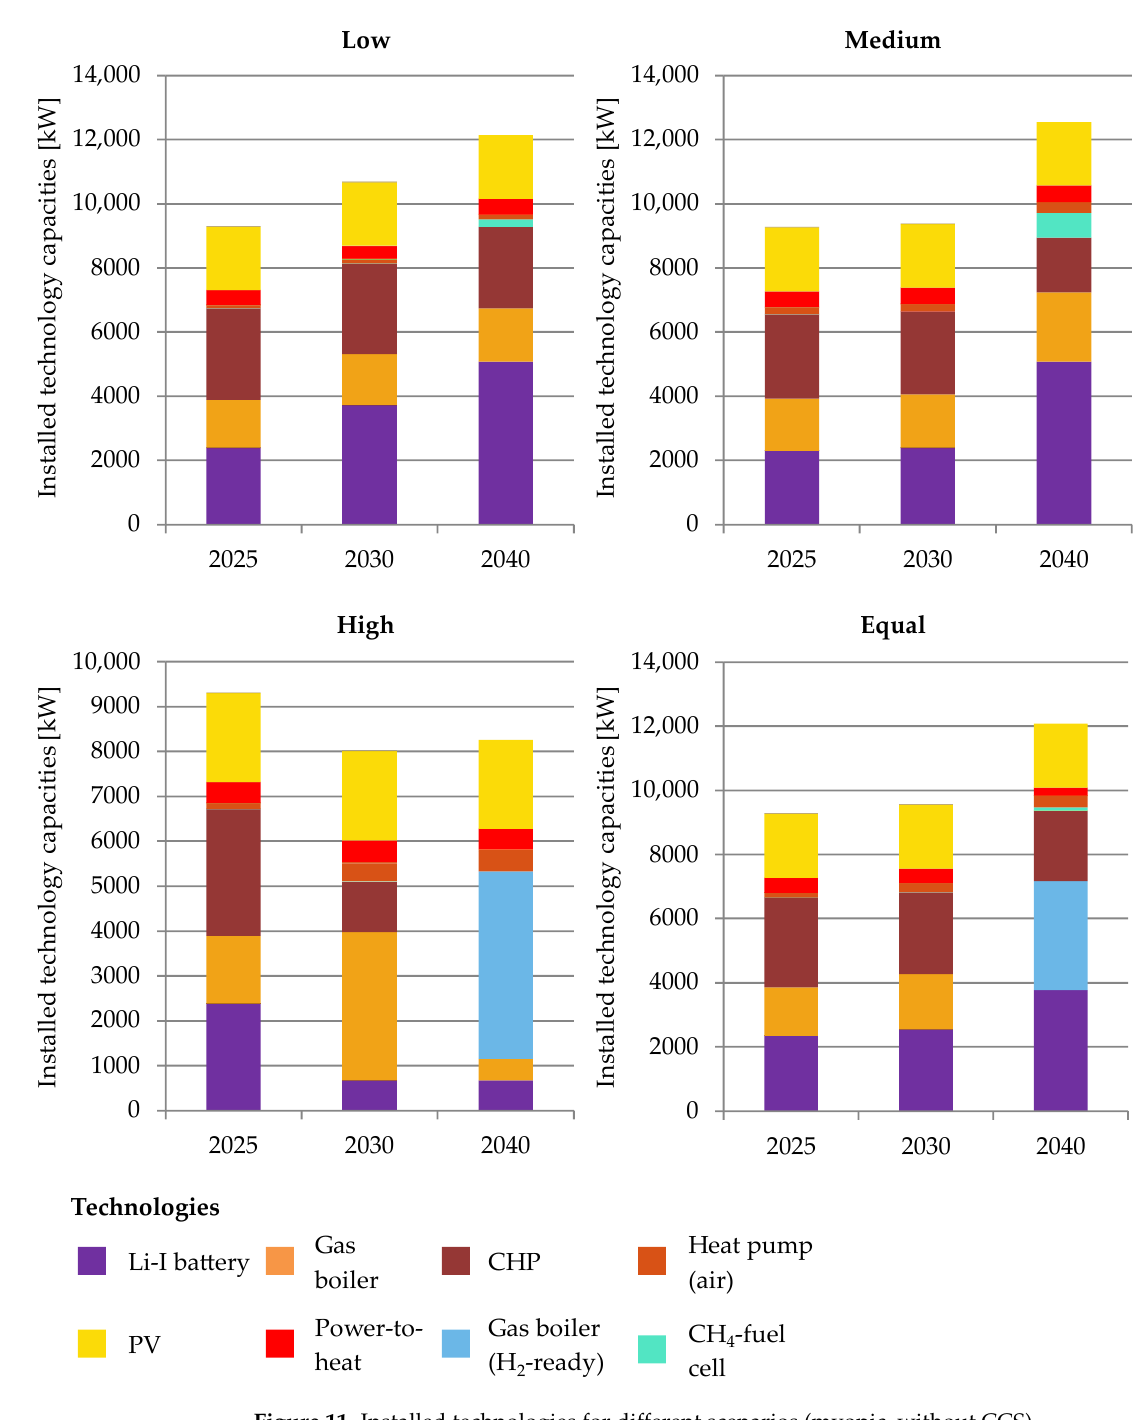
Figure 11. Installed technologies for different scenarios (myopic, without CCS). The significant cost deviation of the high scenario is explainable by the technology switch from gas to hydrogen and the missing CHP in 2040, which reduces the flexibility of the energy system in the high scenario. Figure 12 illustrates the missing flexibility by displaying the energy generation and system cost of the low scenario and the scenario optimised for the high price pathway, but with low CO 2 price s (“planned for high but low manife sts”).